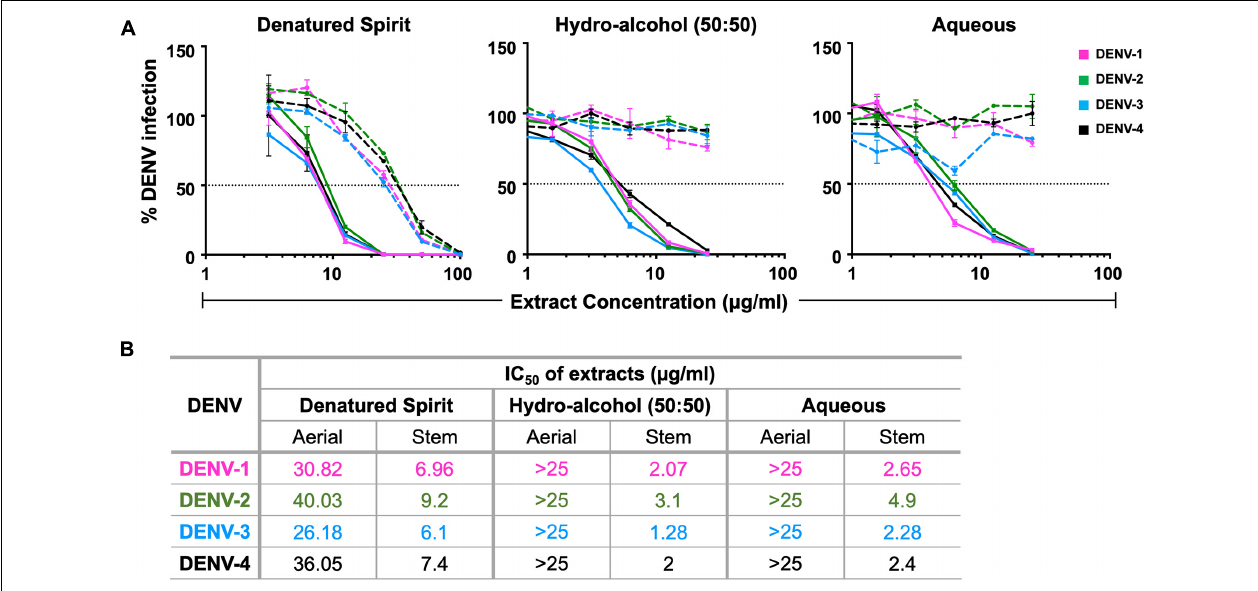
FIGURE 1 | Evaluation of extracts of aerial and stem parts of C. hirsutus prepared using various extraction solvents: extracts of aerial and stem only parts of C. hirsutus were prepared in different solvents, viz ., denatured spirit, hydro-alcohol (50:50), and aqueous. Anti-dengue activity of each of these extracts at various concentrations was evaluated against DENV-1 (magenta curve), DENV-2 (green curve), DENV-3 (blue curve), and DENV-4 (black curve) by flow-cytometry-based virus inhibition assay. (A) % Dengue virus (DENV) infection relative to virus control achieved is represented graphically for denatured spirit (left panel), hydro-alcohol, 50:50 (middle panel), and aqueous (right panel) aerial (dashed curves) and stem (solid curves) extracts. (B) Concentration of extract ( µ g/ml) that resulted in 50% inhibition of viral infection as compared with virus control [represented by horizontal dotted line in panel (A) ], calculated as IC 50 using Graphpad Prism, is shown in table for all